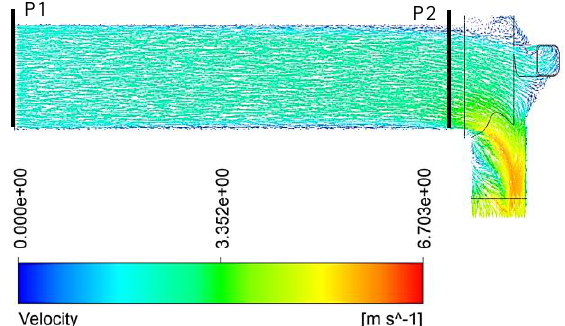
Fig. 7. Velocity vectors in the symmetry plane of the suction line for revolutions n p = 3 000 min -1 , oil temperature t = 50 °C, Laminar model